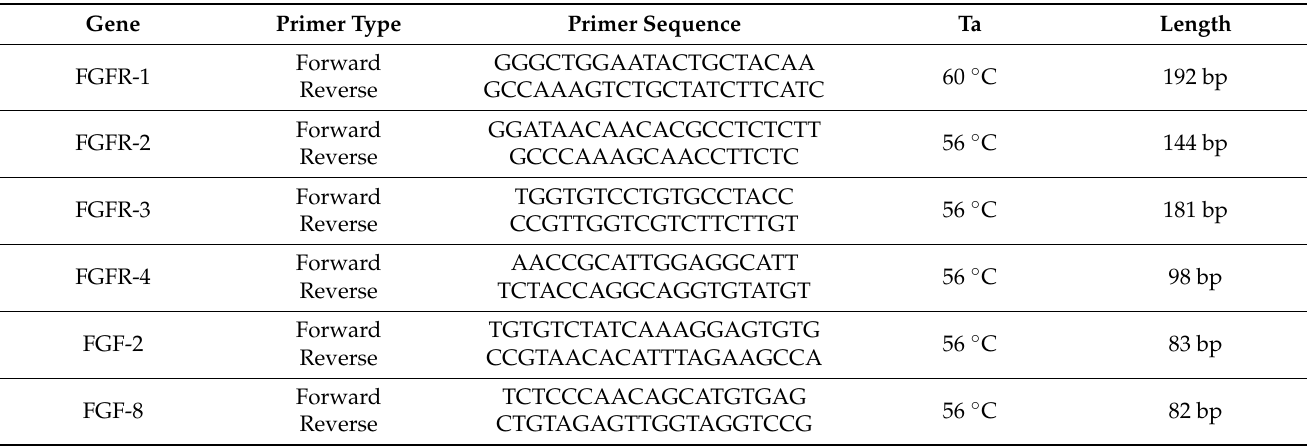
Table 1. Primer sequence, annealing temperature (Ta) and expected length of PCR product in base pair